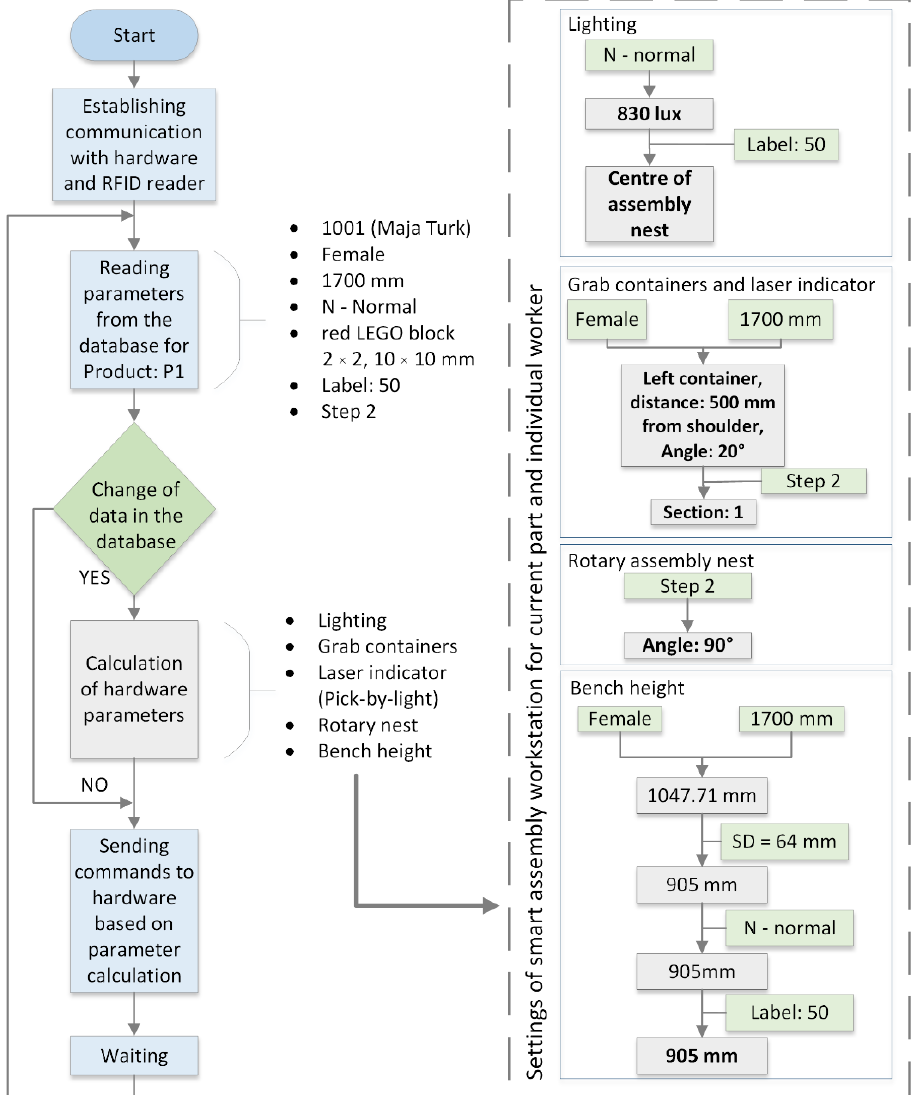
Figure 3. Block diagram of a multi-criterial algorithm for step 2.